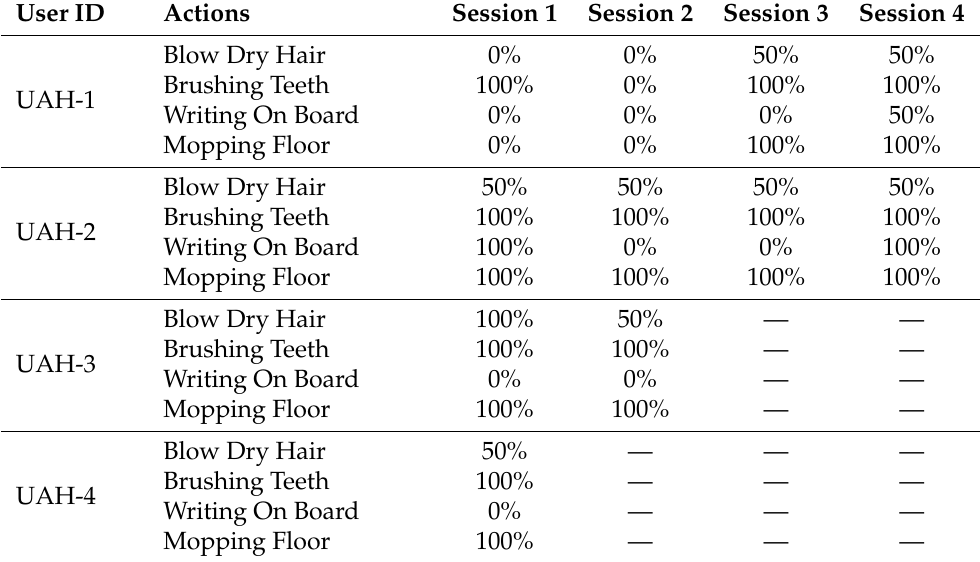
Table 2. This table details the results of the entire process of technical validation of the platform. We report the average accuracy of the AI model when recognizing the actions during the different sessions. Our OAD model has detected the actions of brushing teeth and mopping the floor with the highest accuracy during the sessions. Considering the patients’ physical limitations, blow drying hair, and writing on board were challenging activities for them to undertake. User ID Actions Session 1 Session 2 Session